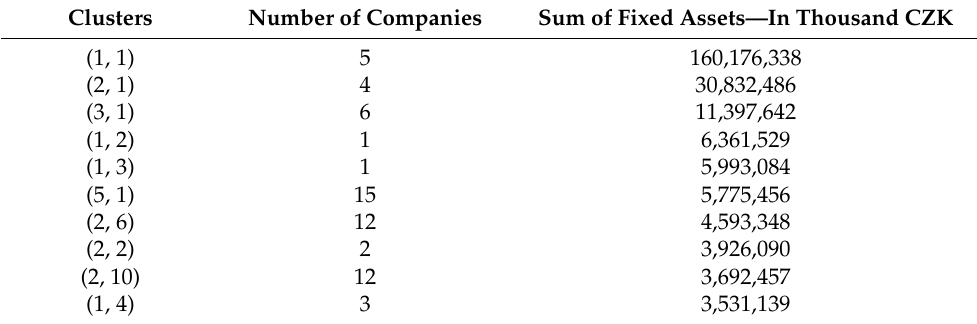
Table 13. Table of ten clusters with the highest total sum of fixed assets for the year